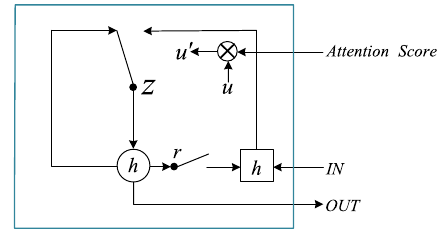
Figure 1. The architecture of